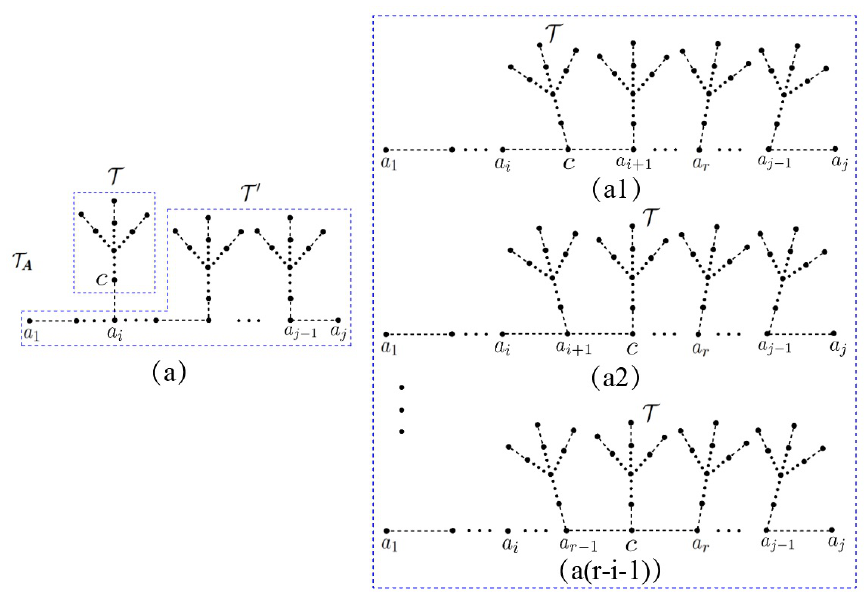
Figure 9 . Graph T AAA in (a) can be separated into two subtree sturctures T and T 0 . Graphs (a1), . . . , (a(r-i-1)) denote the contributions of the sets of simple chains that are corresponding to (4.52), (4.53), . . . and